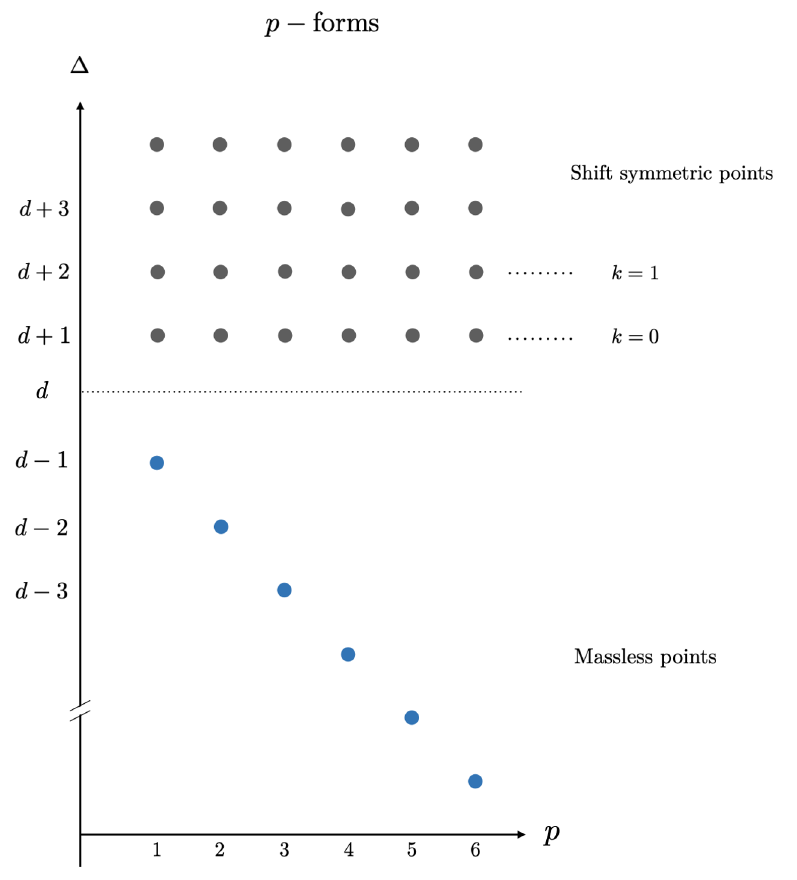
Figure 1 . p form fields in the conformal dimension ∆ vs. p plane, for the values ∆ + . The masses are given by m 2 L 2 = (∆ − p )(∆ − d + p ) . Blue dots are the massless points, black dots are shift symmetric points. For each p the unitarity bound coincides with the massless